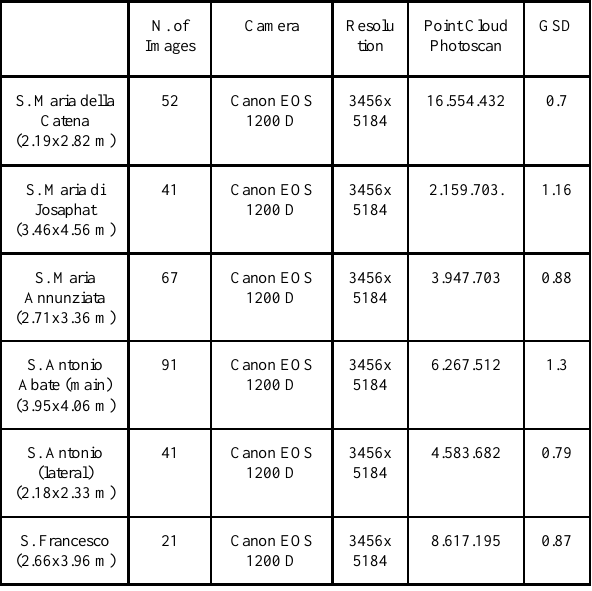
Table 1. Summary of datasets of the point clouds derived from Image Based